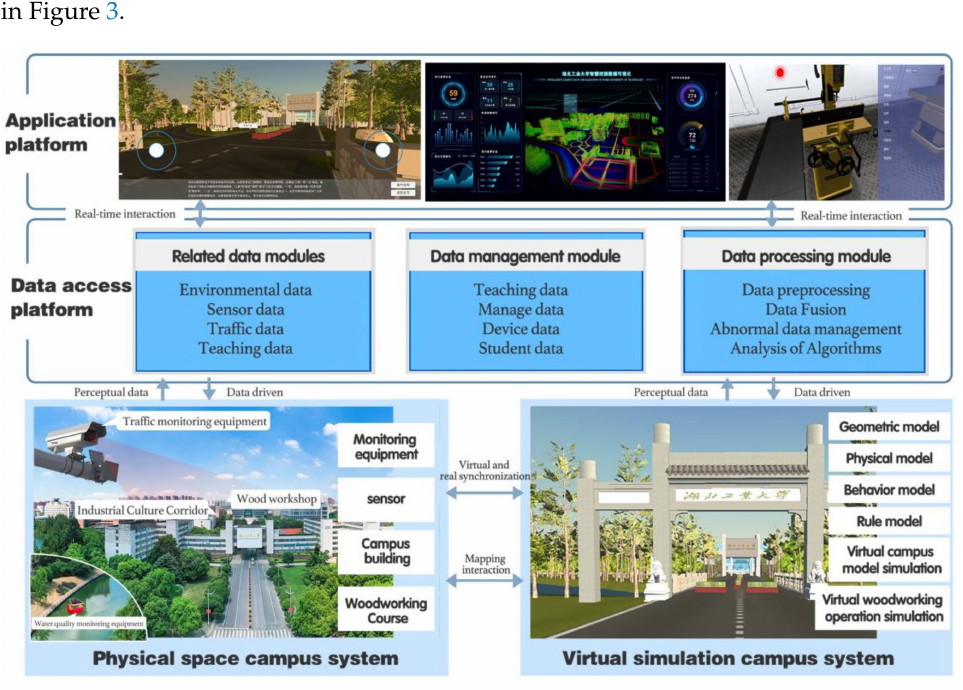
Figure 3. A logical framework for the Digital Twin Smart